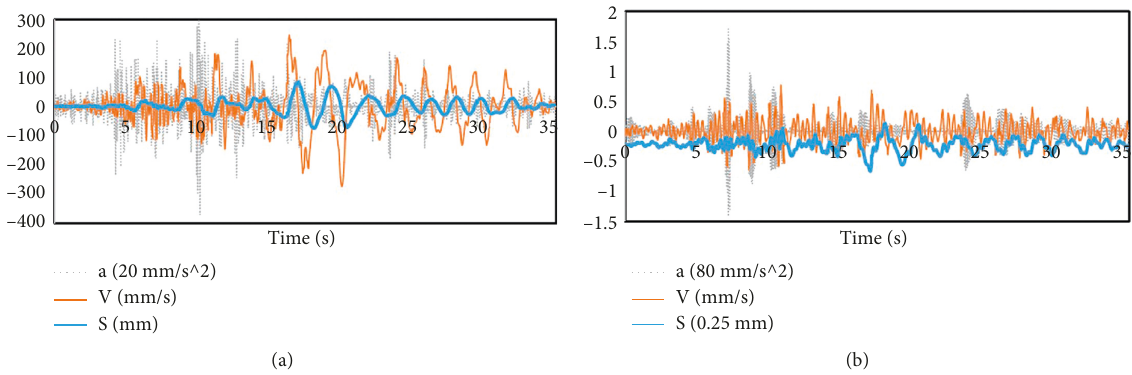
Figure 52: Time course curves of bearing deformation displacement, velocity and acceleration when LWD is input from Y direction. (a) Horizontal deformation. (b) Vertical deformation.